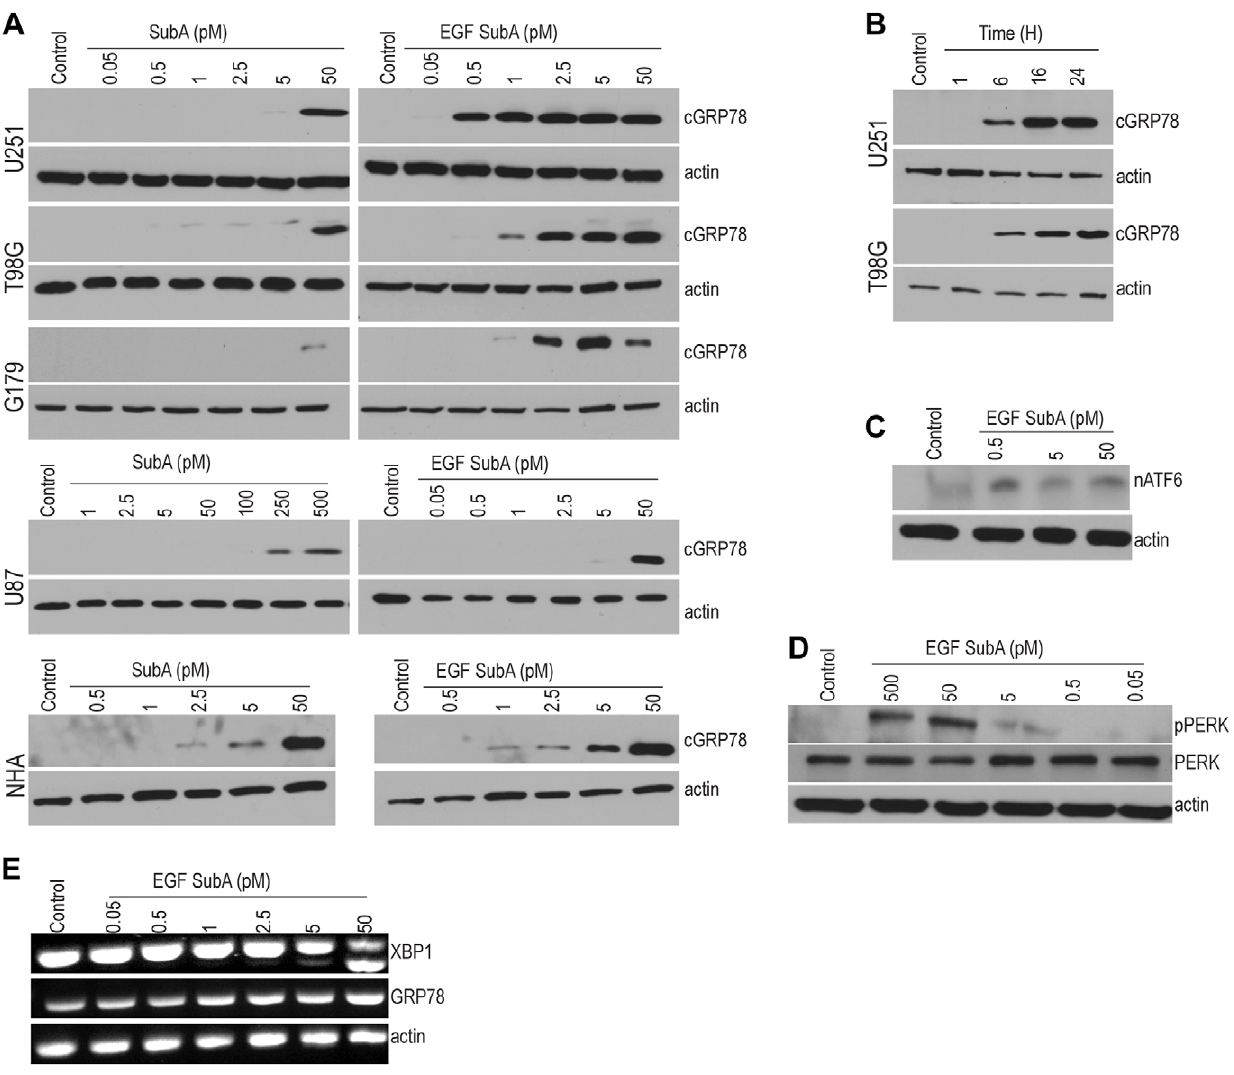
Figure 2. SubA and EGF-SubA cleaves GRP78 and activates the UPR. Exponentially growing glioblastoma cell lines and normal human astrocytes (NHA) were (A) treated with SubA or EGF-SubA at the specified picomolar concentrations for 24 h or (B) exposed EGF-SubA (1 pM) for the specified time periods. Total cellular protein was isolated and immunoblotting was performed with anti-GRP78 antibody. SubA and EGF-SubA cleaved the endogenous GRP78 (78 kDa) resulting in an additional smaller fragment of 28 kDa (cGRP78). (C-E) Total cellular protein and RNA were isolated from U251 cells exposed to EGF-SubA at the stated concentrations for 24 h. EGF-SubA induced GRP78 cleavage resulted in nuclear localization of ATF6 (C; nATF6), a dose-dependent phosphorylation of PERK (D; pPERK), and Ire1 activation, determined by Xbp1 mRNA splicing (E). Each figure is a representative of three independent experiments.